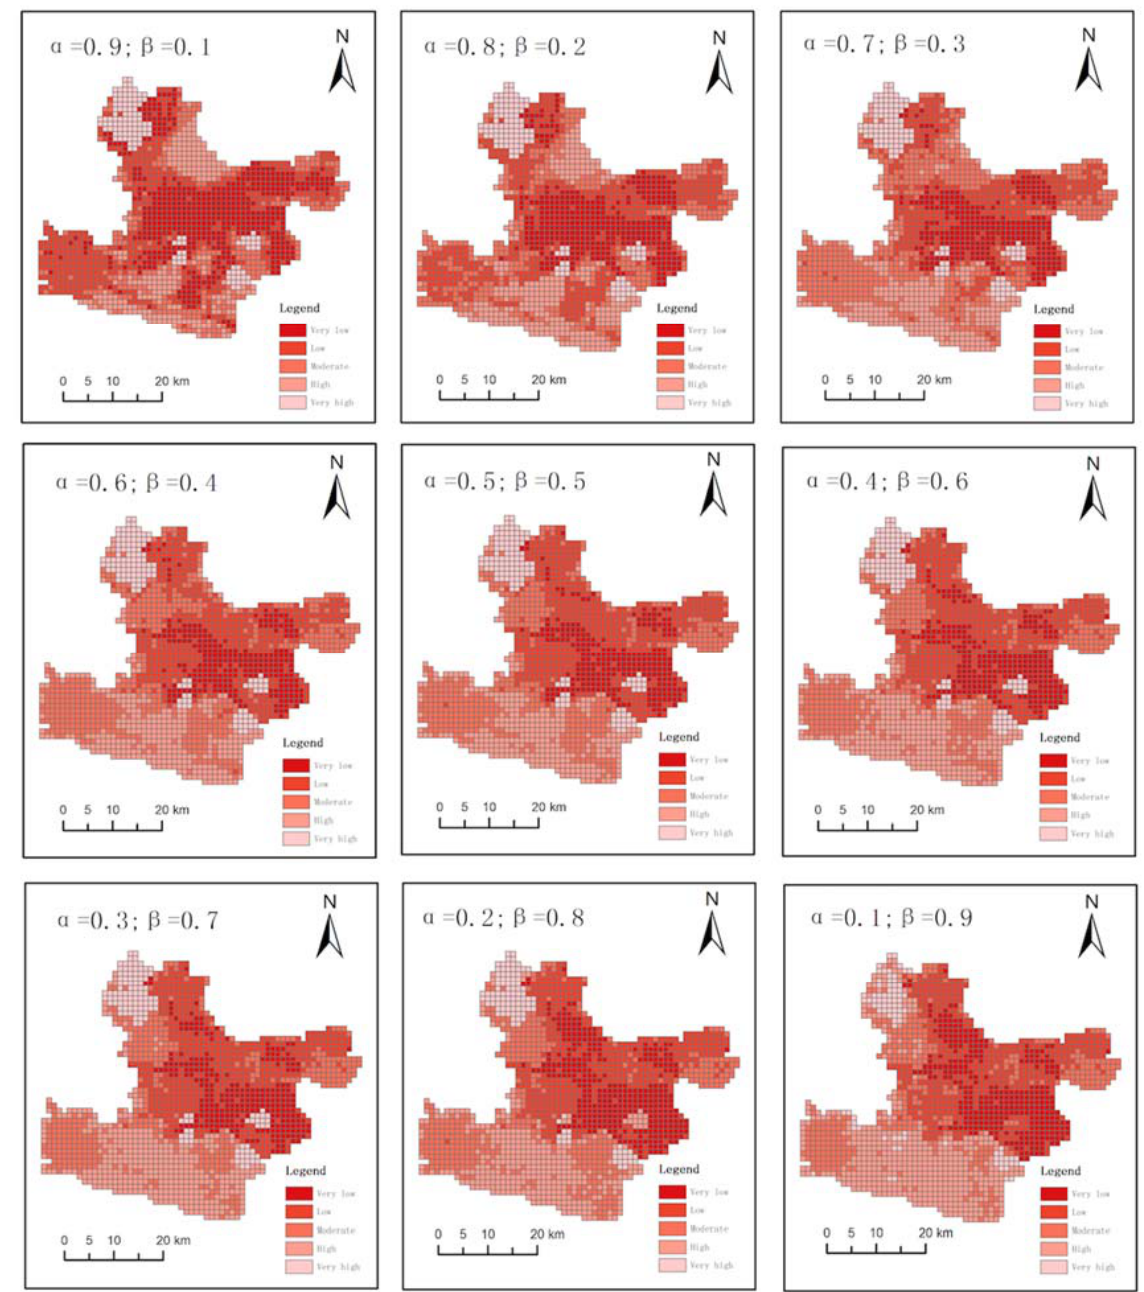
Figure 3. Map of regional land eco-security distribution on Daye. The ESI is classified as: very low (<0.101), low (0.101 < ESI < 0.112), moderate (0.112 < ESI < 0.125), high (0.125 < ESI < 0.151), and very high (>0.151).